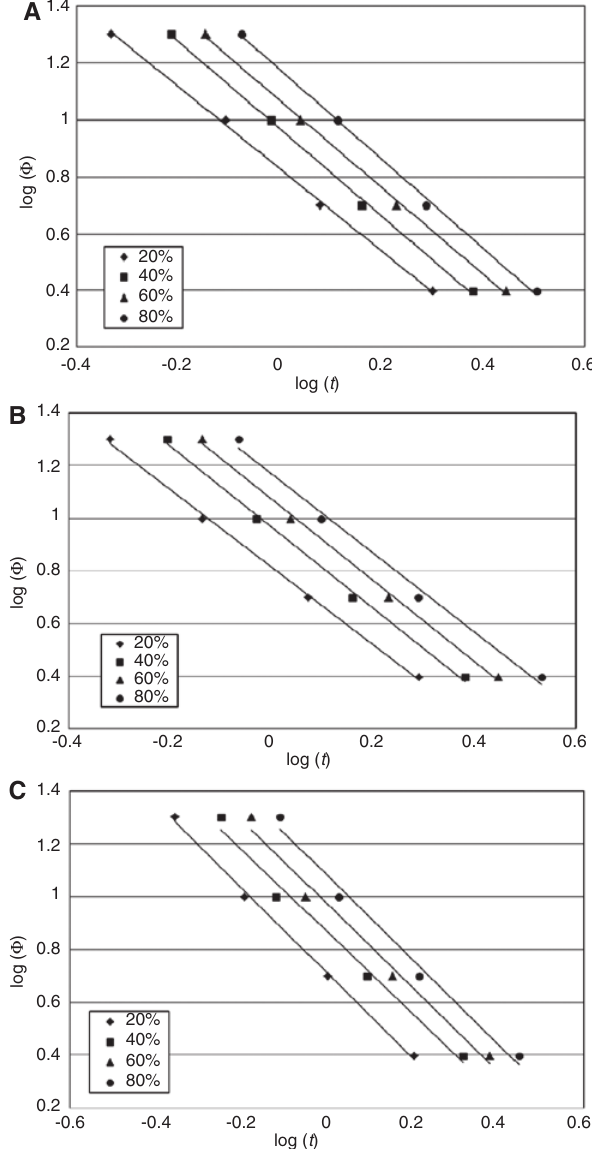
Figure 6: Mo’s plots of (A) neat polypropylene (PP), (B) PP-25 date palm fiber (DPF)-5MA and (C) PP-50